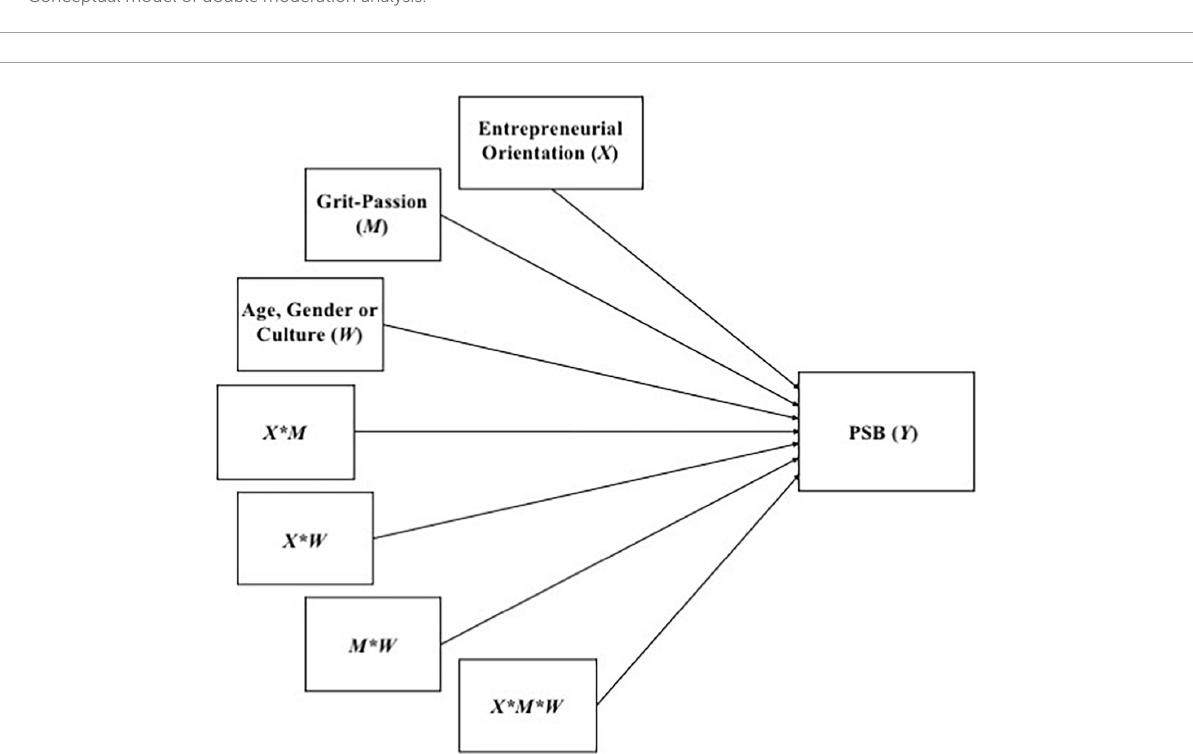
FIGURE3 Multiple linear regression analysis for the double moderation model. *Interaction between variables.